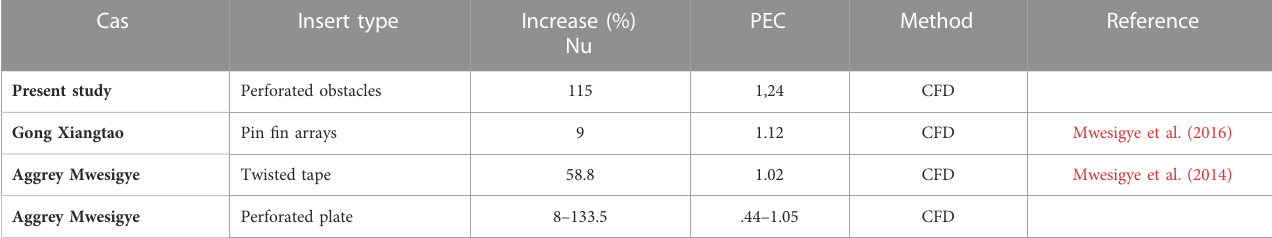
TABLE 5 Comparison with literature studies with inserts in the receiver of a parabolic trough solar collector and the present